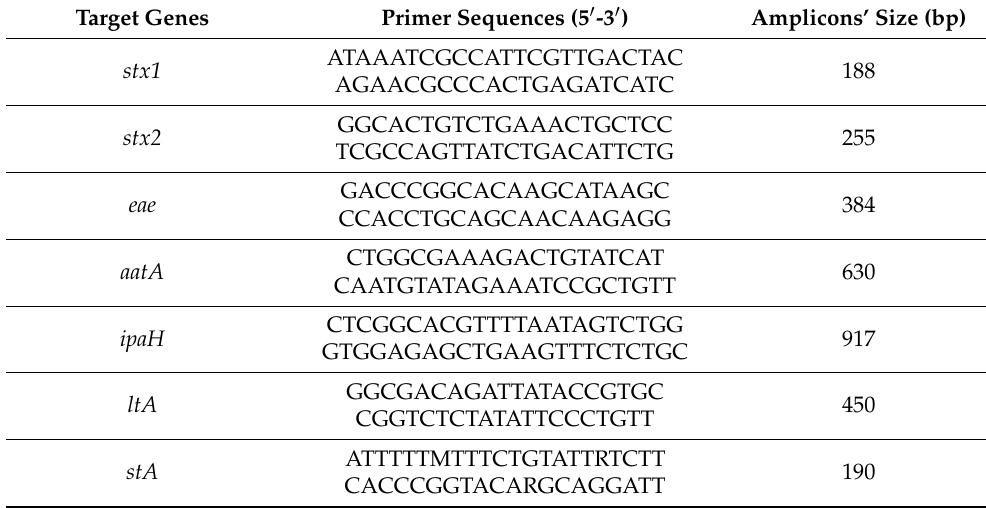
Table 3. Virulence factor primer sequences and amplicon sizes used in this study. Target